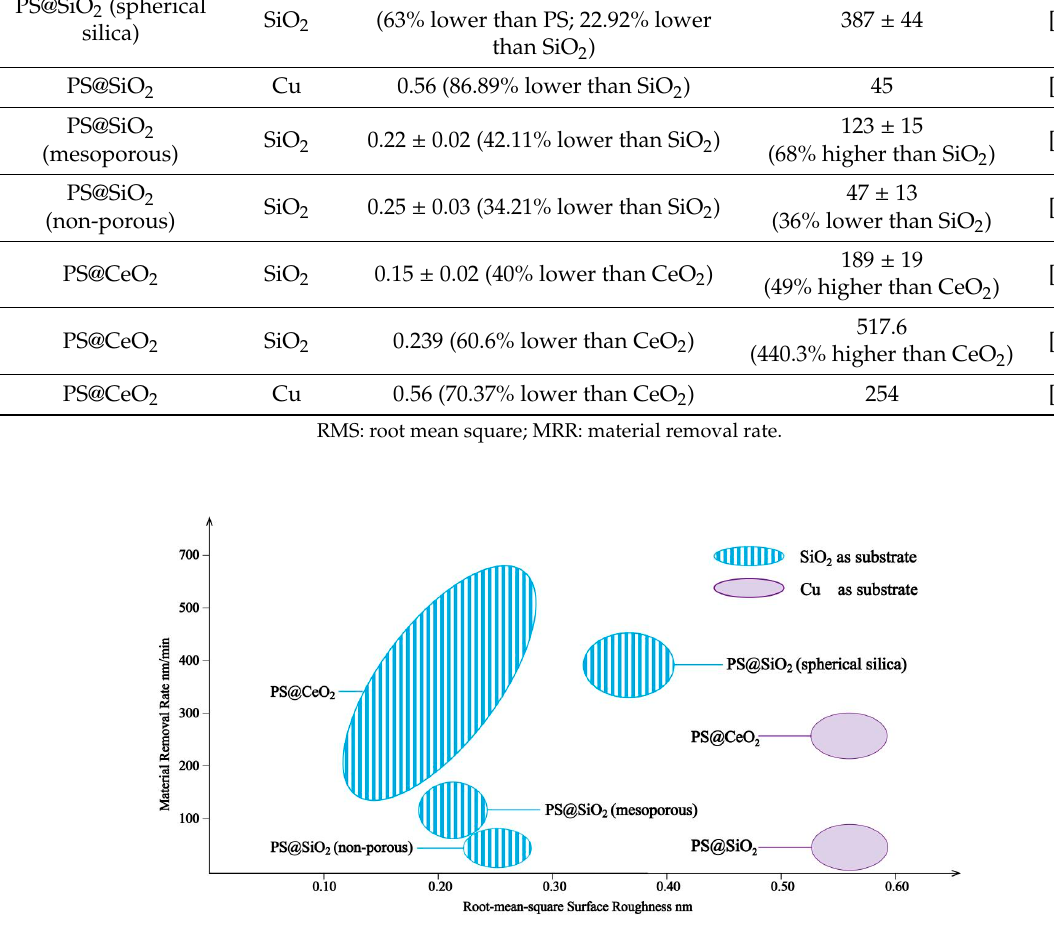
Figure 17. CMP behavior of the core–shell particles as abrasives.